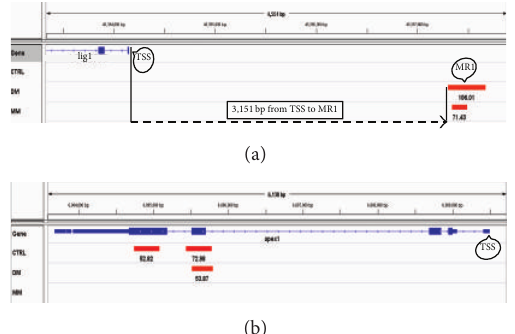
Figure 5: Methylated DNA regions (MRs) of zebrafish gene loci for lig1 (a) and apex1 (b). Panels (a) and (b) were prepared with IGV genome viewer. The scale on the top shows chromosomal coordinates. This program schematically represents the structure of thegeneusingconventionalelements:(1)bluelinerepresentsintrons and (2) blue blocks on the line represent exons. Circles with the “TSS” point to the transcription start site and the dashed arrow points in the direction of 5 󸀠 to 3 󸀠 of the DNA strand with the arrow pointing to the MR farthest upstream of the TSS as indicated for each diagram (bp distance indicated in the box above the dashed arrow). Three tracks separated by gray lines below gene track show localization of MRs for each of the three samples to include control (CTRL), diabetic state (DM), and metabolic memory state (MM). Methylated regions detected by the MACS algorithm are shown as red boxes. Those upstream of the TSS that have a loss of methylation in the DM and/or MM states are numbered (MR1, MR2, etc.) with the MACS peak ID numbers under each MR. (a) lig1 , (b) apex1 . The MRs of apex1 are all located within the ORF and are not numbered, although they show a loss of methylation in the DM and/or MM as seen with dnmt1 , mcm2 , and orc3 . In contrast lig1 which did show upregulation in gene expression in the DM and MM states showed the opposite methylation pattern with the control state showing no MRs while the DM and MM states showed the appearance of MRs (Figure 5(a)).